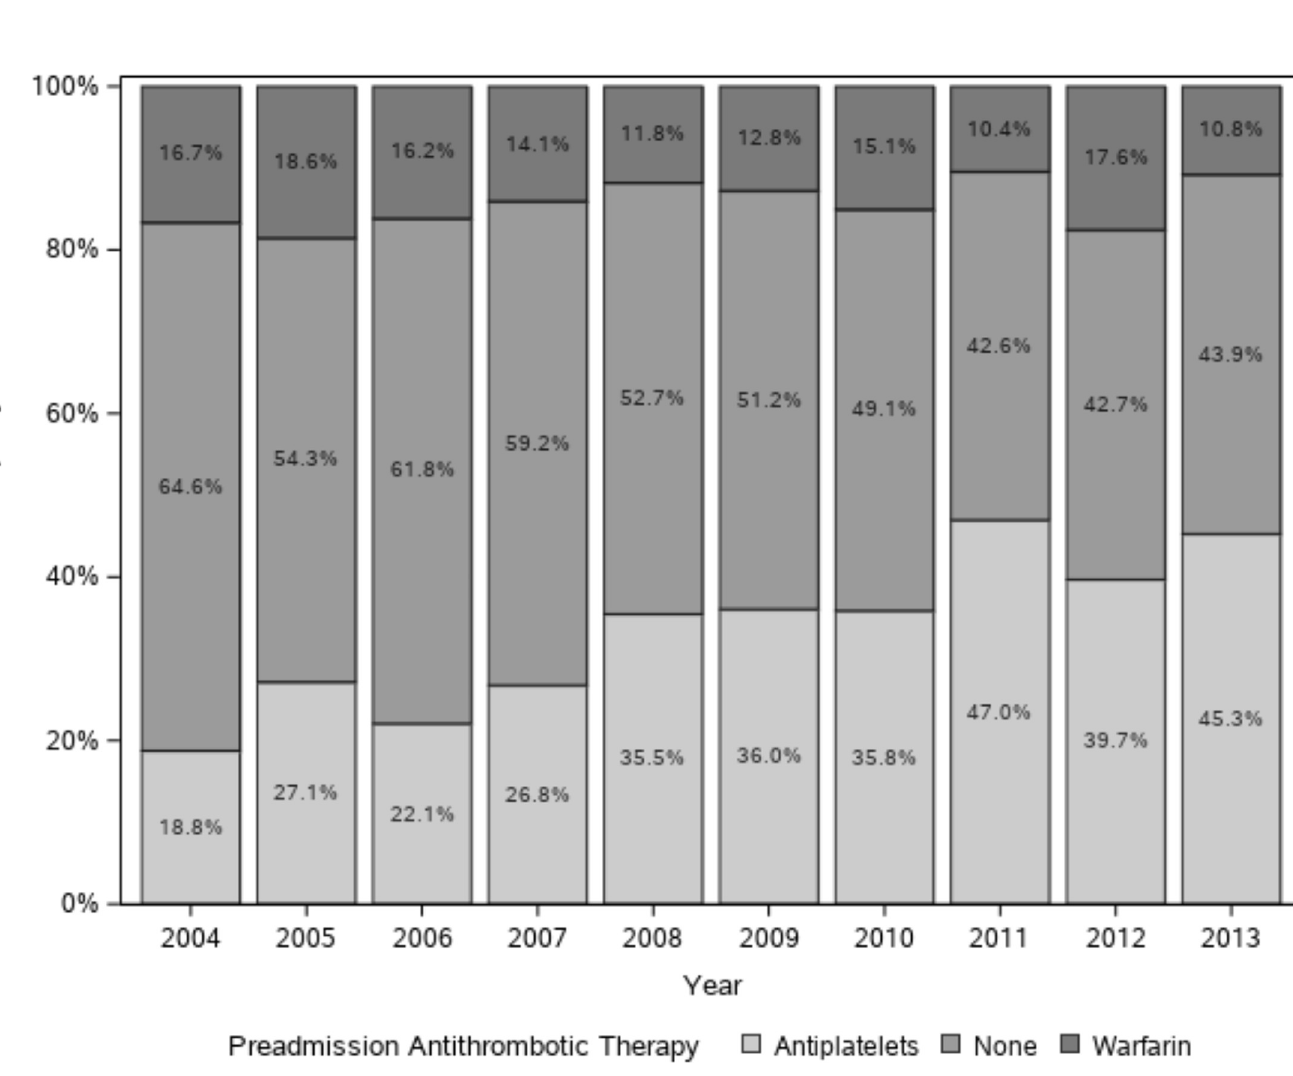
Fig 3. Preadmission antithrombotic therapy in OAC therapy candidates � . � Patients with CHA 2 DS 2 -VASc score � 2 before acute ischemic stroke event were selected.